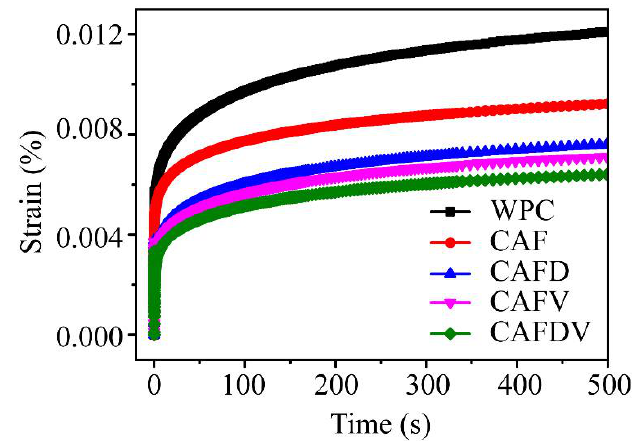
Figure 11. Creep curves of the CAF-reinforced